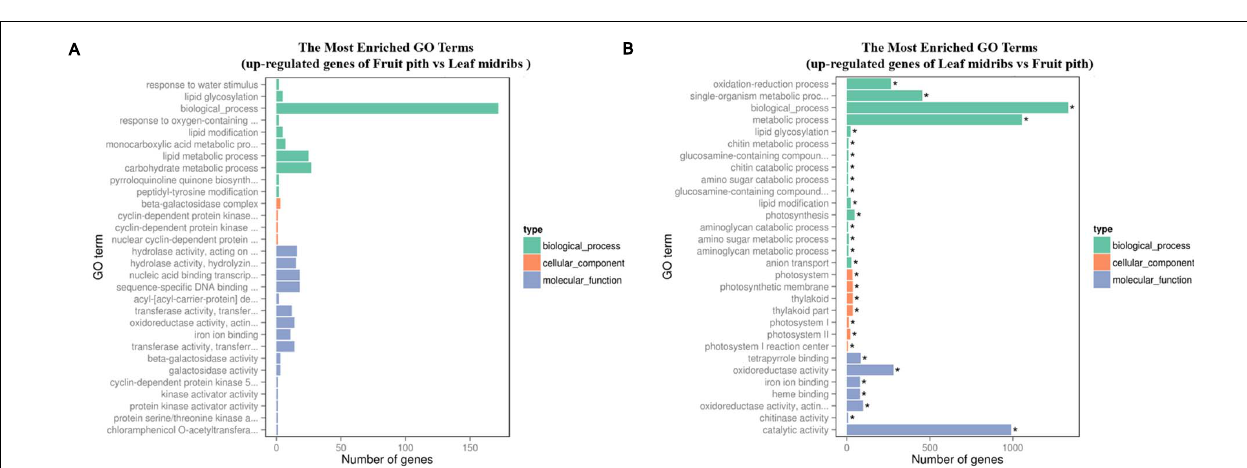
on CLas populations in fruit piths among different